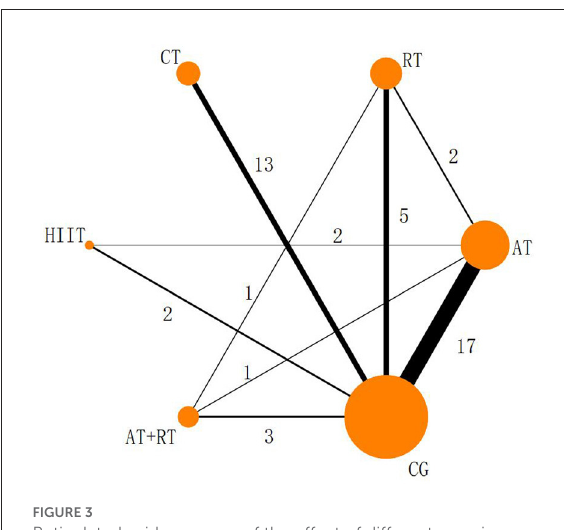
FIGURE3 Reticulated evidence map of the effect of different exercise modalities on serum BDNF levels. Each node (solid circle) represents only one type of rehabilitation treatment. The size of the nodes is proportional to the number of subjects involved in the particular treatment intervention (i.e., sample size). The solid line connects the treatment with a direct comparison whose thickness is proportional to the number of trials.